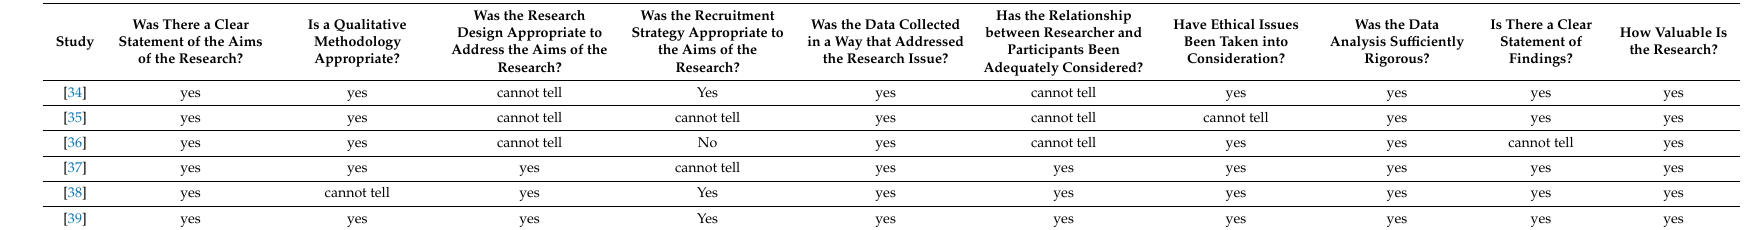
Table 4. Assessment of risk of bias in qualitative